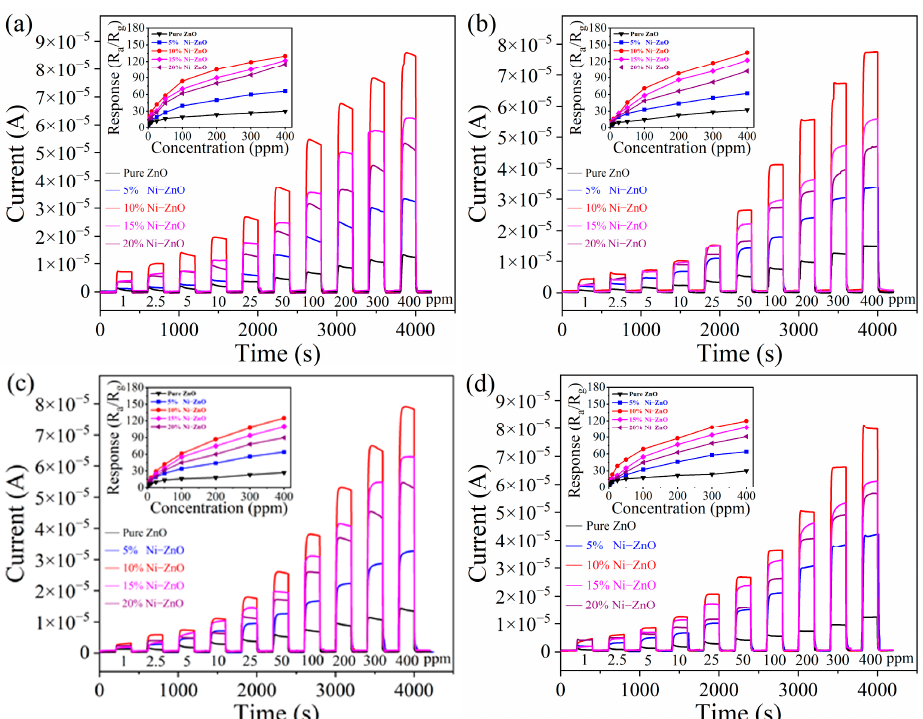
Figure 7. Real-time response curves of the sensor devices upon exposure to different concentrations of ( a ) formaldehyde, ( b ) acetone, ( c ) ethanol, and ( d ) isopropanol at a working temperature of 220 °C. The insets show the corresponding sensor response curves.